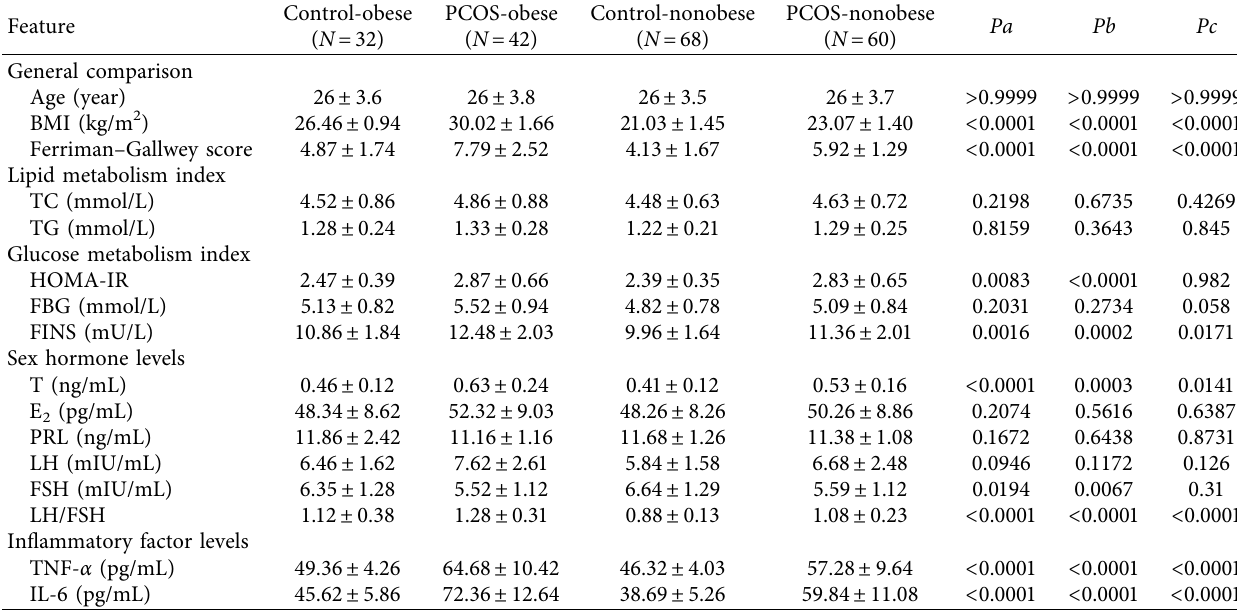
Table 2: Comparison of clinical baseline data between obese and nonobese PCOS patients and healthy subjects.